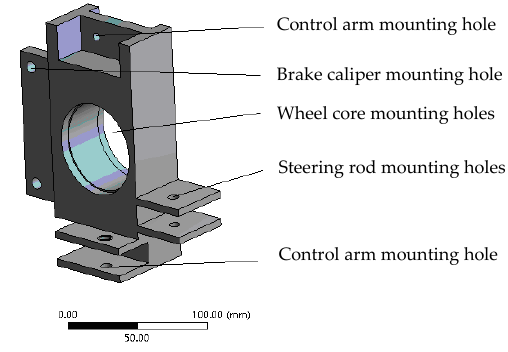
World Electric Vehicle Journal 2019 , 10 ,